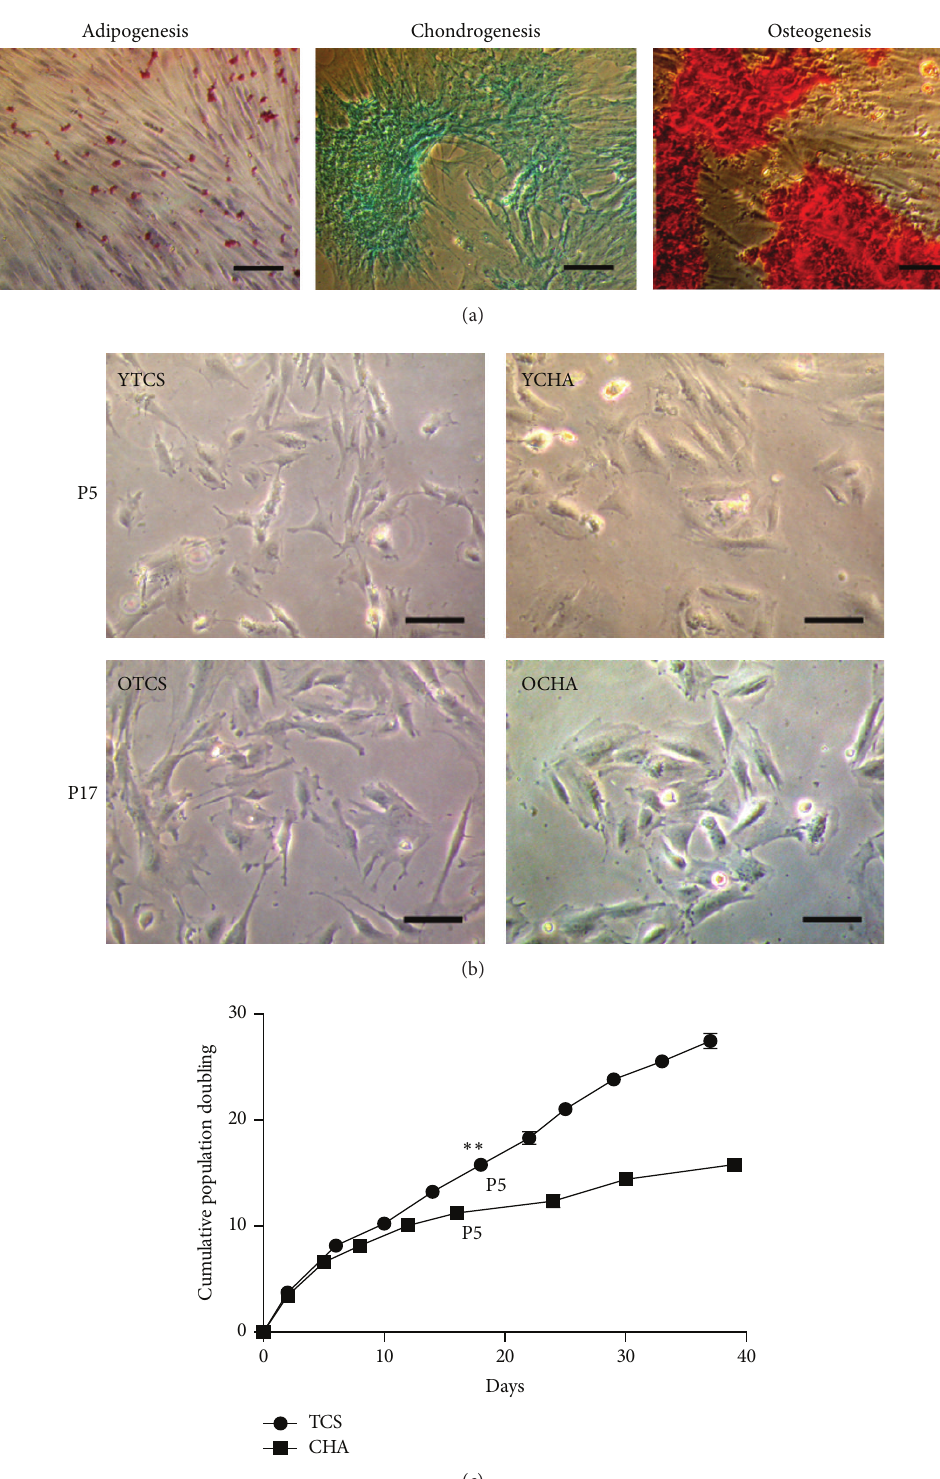
Figure 1: Hyaluronan-coated surface affected cell proliferation of PDMSC. (a) The PDMSC grown on tissue-culture polystyrene surface differentiated to adipocytes, chondrocytes, and osteocytes after induction for 4 weeks. Scale bar = 100 𝜇 m. (b) The PDMSC presented fibroblastic morphology on tissue-culture polystyrene surface (TCS) and formed aggregate on tissue-culture polystyrene surface coated with 30 𝜇 g/mL hyaluronan (CHA). The cells at P5 are noted as young and P17 as old. In CHA, the culture of PDMSC on HA-coated surface began at P2; thus, P2 + 3 passages (P5) and P2 + 15 passages (P17) for young and old CHA, respectively. Scale bar = 100 𝜇 m. (c) The proliferation of PDMSC on TCS and CHA grown for a period of 5 weeks. Each of the data points represents cumulated population doubling for one passage. Three independent experiments were performed in TCS and CHA and data are represented in mean ± SD. ∗∗ 𝑃 value < 0.01